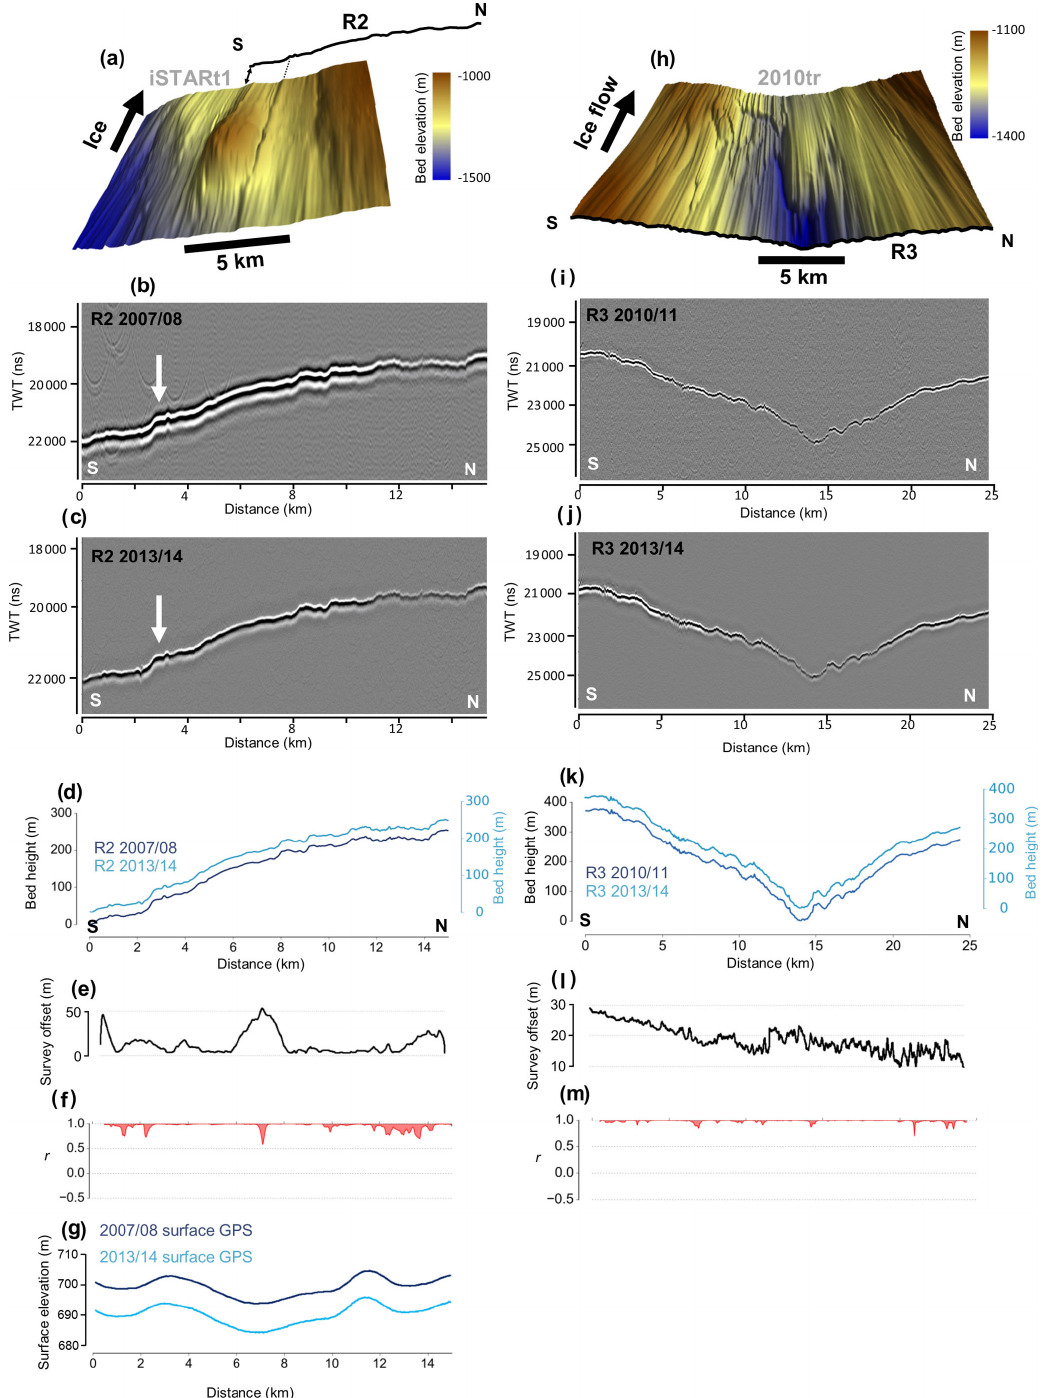
Figure 3. Geophysical data and bed picks from PIG. (a) Radar derived bed DEM (Bingham et al., 2017) showing the location of survey R2 2km downstream. (b, c) Processed radargrams of repeat radar surveys. (d) Bed picks from repeat radar survey R2. (e) Plot showing the survey divergence between radar profiles in 2007/2008 and 2013/2014. (f) Correlation coefficient of repeat bed picks between 2008/2009 and 2013/2014 across a 500m moving window. (g) Plot of surface elevation profiles derived from differential GPS measurements. (h) Radar derived bed DEM (Bingham et al., 2017) showing the location of survey R3 at the upstream limit of the radar grid. (i, j) Processed radargrams of repeat radar surveys. (k) Bed picks from repeat radar survey R3. (l) Plot showing the survey divergence between radar profiles in 2007/2008 and 2013/2014. (m) Correlation coefficient of repeat bed picks between 2010/2011 and 2013/2014 across a 500m moving window.